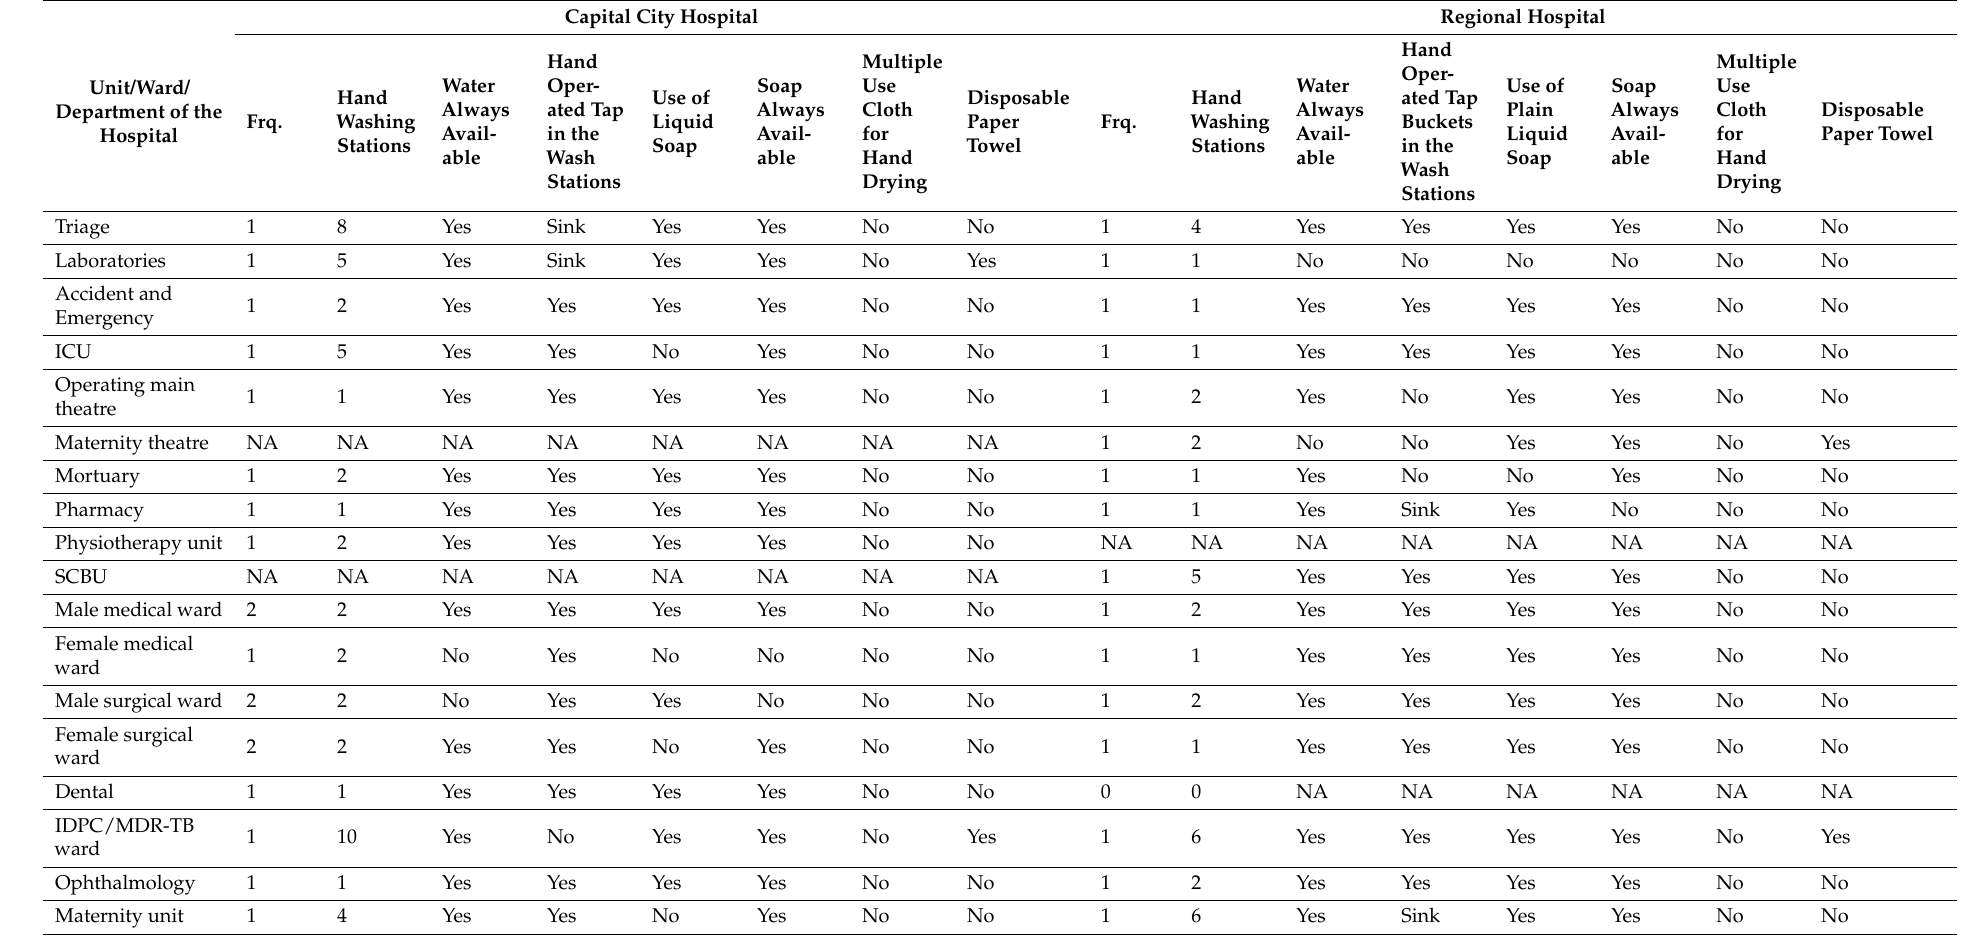
Table 2. Hand hygiene facilities in two hospitals in Sierra